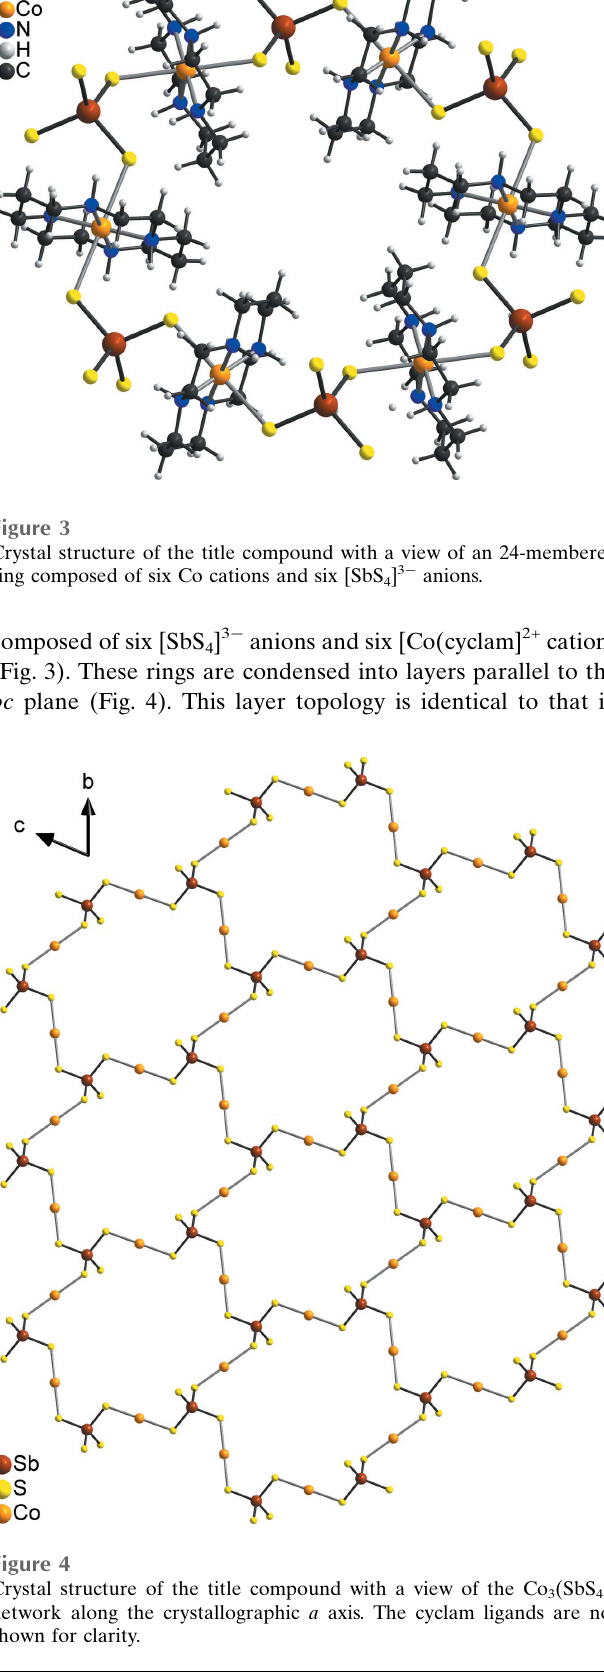
Table 1 Selected bond lengths (A˚ ).